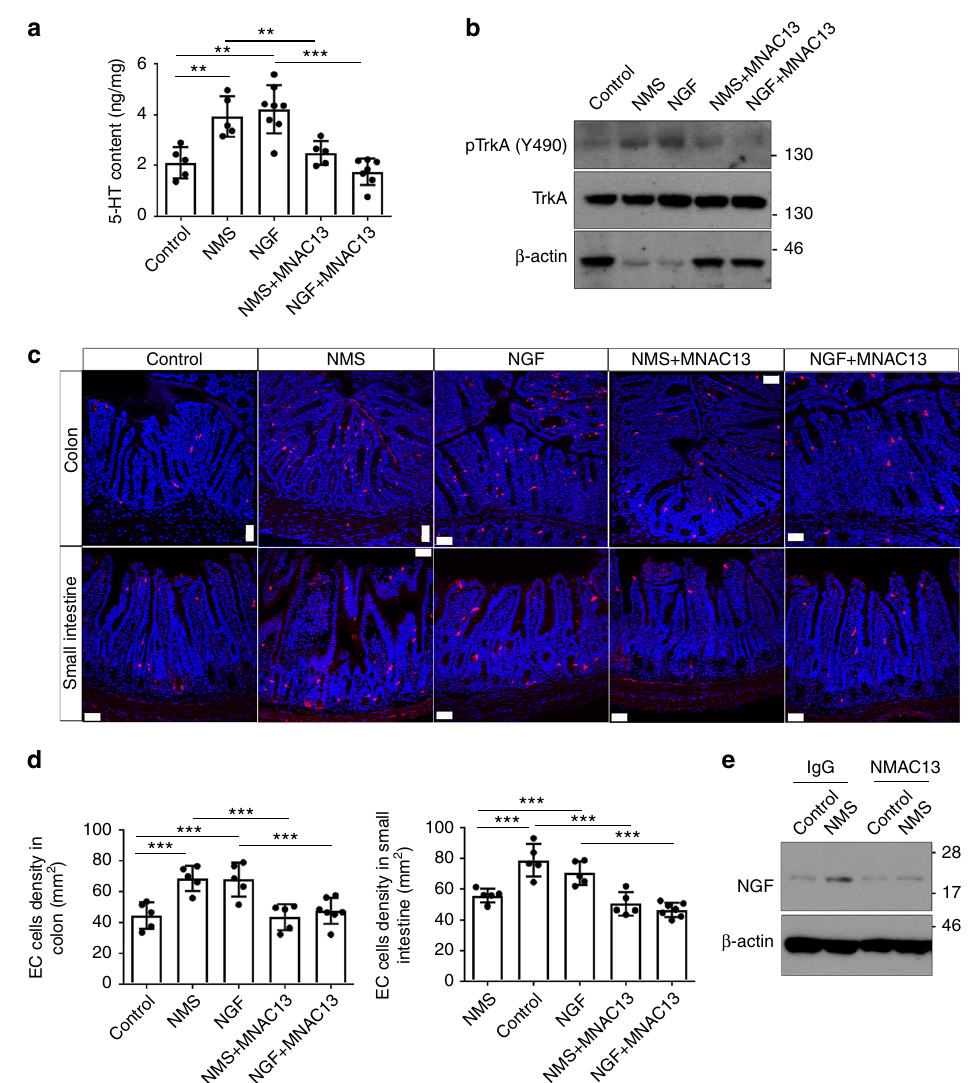
Fig. 1 NMS leads to EC cell hyperplasia and increased enteric serotonin via NGF/TrkA signaling. a The concentration of serotonin/5-HT in the proximal colons isolated from control and NMS mice treated with/without NGF and MNAC13 was measured at 8 weeks upon NMS treatment. ** p < 0.01; *** p < 0.001, n ≥ 5/group; ANOVA. b Western blotting analyses on the expression of p-TrkA (Y490) in the tissues isolated from a . The protein loading for total TrkA was normalized and served as a loading control. c Immunostaining for serotonin/5-HT shows the distribution of serotonin-producing EC cells in both small intestines and proximal colons from control and NMS mice treated with/without NGF and MNAC13 (scale bar: 50 μ m). d Quanti fi cation for the densities of EC cells in both small intestines (right panel) and colons (left panel). *** p < 0.001, n ≥ 5/group, ANOVA. e Western blotting analyses on the expression of NGF in the proximal colons from control and NMS mice treated with/without NMAC13 at 8 weeks upon NMS treatment. β -actin served as a loading control. Data represent the mean ±